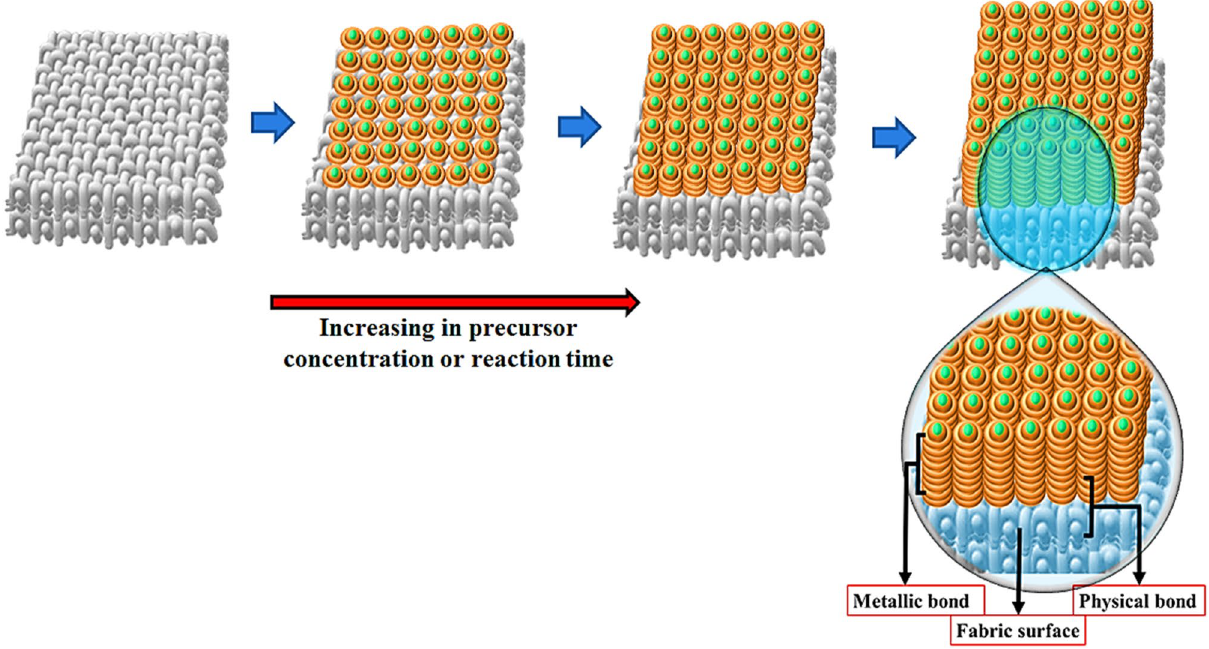
Figure 8. Schematic representation of SNPs bonds on fabrics as a function of precursor concentration and reaction time.